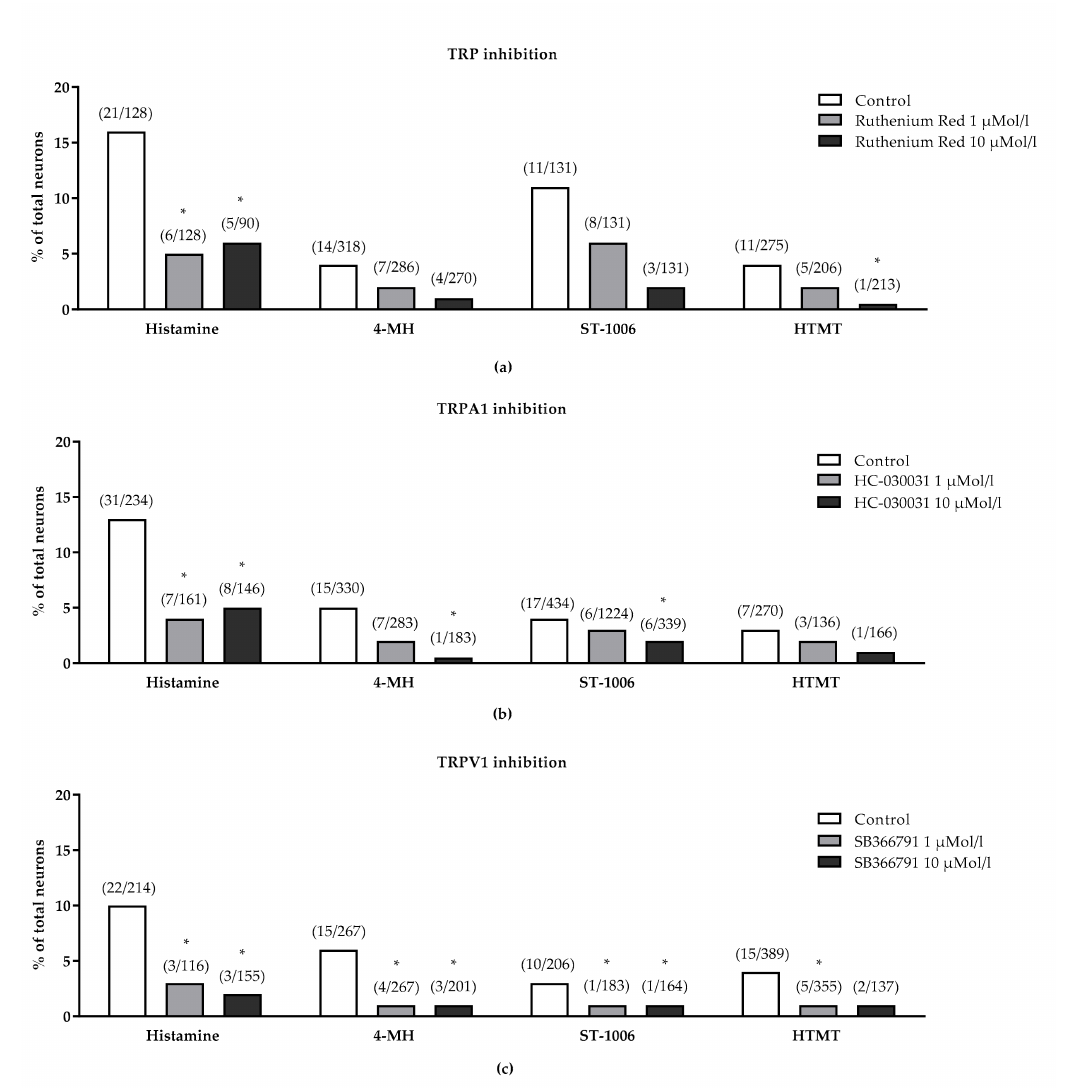
Figure 6. Influence of different TRP channel inhibitors on histamine-induced intracellular Ca 2+ -increase (change in 340/380 nm fluorescence intensity ratio) in DRG neurons of CD-1 mice. Neurons were stimulated with histamine (1 mmol/L), 4-MH (100 µ mol/L), ST-1006 (100 µ mol/L) or HTMT (100 µ mol/L). ( a ) The TRP channel blocker ruthe- nium red concentration dependently inhibited the neuronal response of all histamine ligands tested. ( b ) The TRPA1 channel blocker HC-030031 concentration dependently inhibited the neuronal response to histamine, 4-MH and ST-1006. ( c ) The TRPV1 channel blocker SB366791 concentration dependently inhibited the neuronal response of all histamine ligands tested. Total numbers of reactive cells and their percentage to the total numbers of cells were examined (KCl 150 mmol/L as positive control). * p < 0.05 (Fisher’s exact test) = significantly different from control; DRG neurons were collected from n = 4 mice per inhibitor